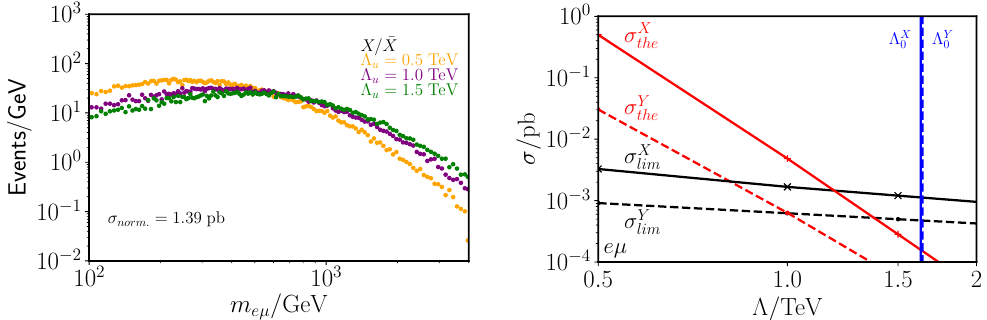
( 0 ) ( 0 ) , (cid:22) with (cid:3) u = 0 : 5, X X O O ( ) in the simple O X O Y ( ) in O X O Y